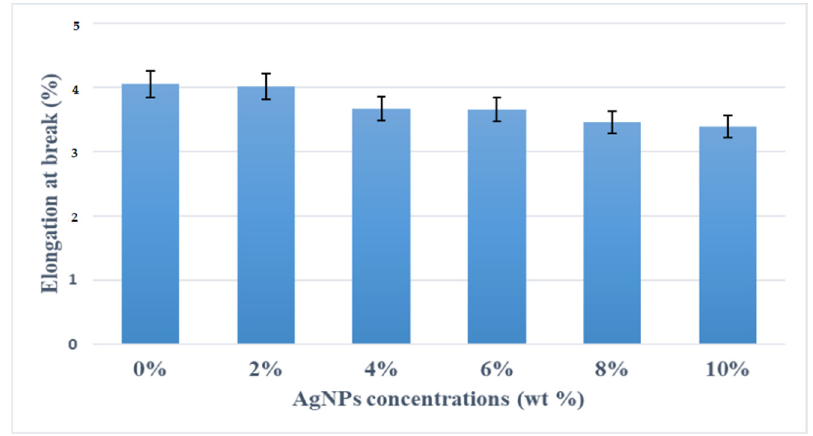
Figure 7. Effects of AgNP content on elongation at break of kenaf/HDPE composites.